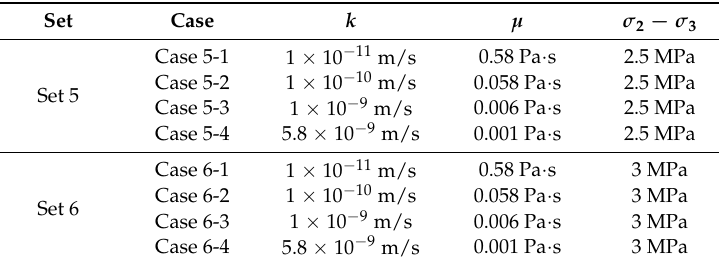
Table 8. Modelling scenarios for studying the validity of Equation (1). The values of parameters related to rock hydraulic conductivity and fluid viscosity are given with various values with other input parameters remaining consistent. The ( σ 2 − σ 3 )/ σ n ratios of modeling Sets 3 and 4 are kept constant as 2.5 and 3 respectively [32].